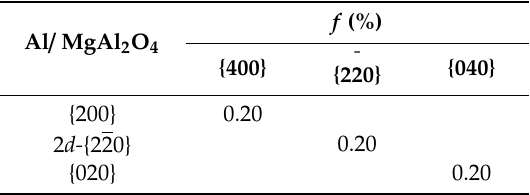
Table 2. The theoretical lattice misfits ( f ) for the parallel crystal planes between Al and MgAl 2 O 4 in Figure